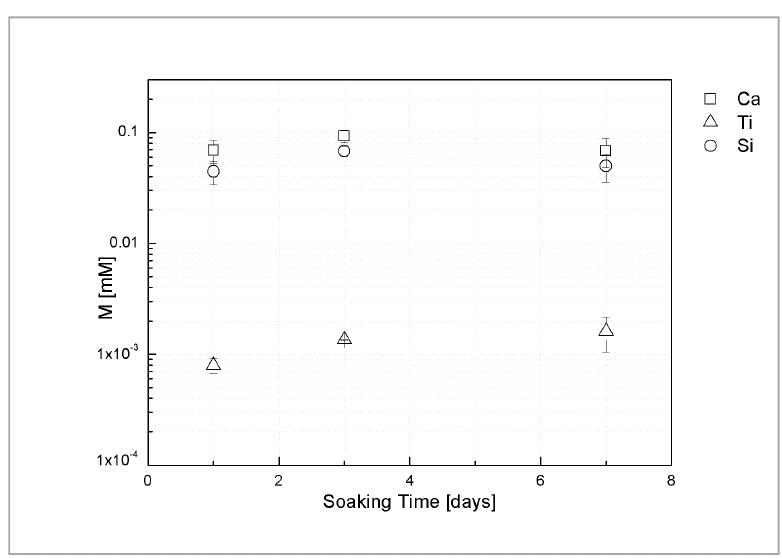
Figure 4. Ca, Ti and Si ion release of sphene-coated samples, after 1, 3, and 7 days of soaking time.